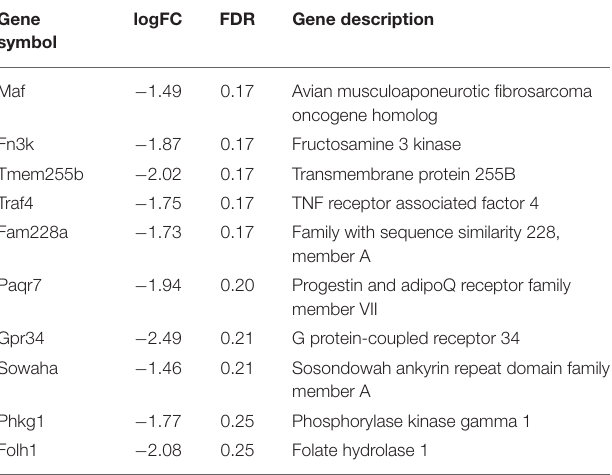
TABLE 4 | Selection of relevant Gene Ontology (GO) and Kyoto Encyclopedia of Genes and Genomes (KEGG) terms of the differentially expressed genes in glia in the contralateral hippocampus (CLH) at 24h after kainate-induced status